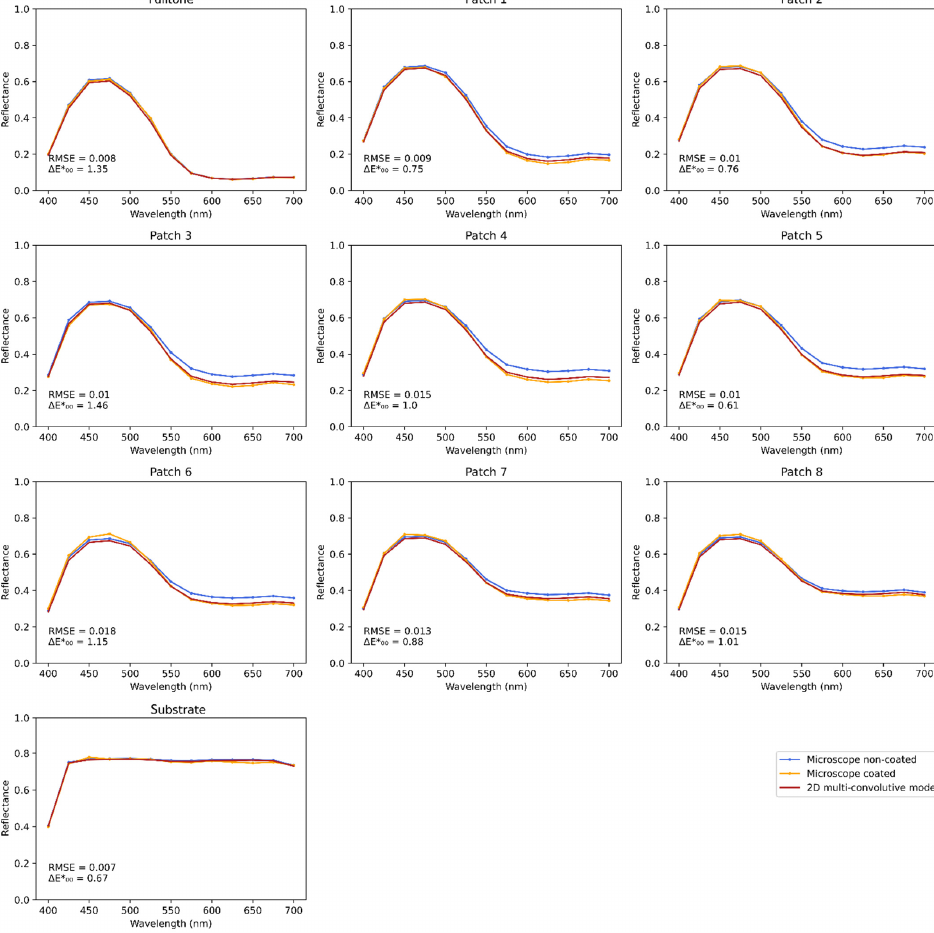
Figure 8. Line cyan halftone reflectance spectra, averaged over the spatial dimension. Patch 1 to 8 have a period of 0.168, 0.250, 0.334, 0.420, 0.504, 0.841, 1.259, and 2.104 mm, respectively. A specular component of 0.04 is added to all spectra.